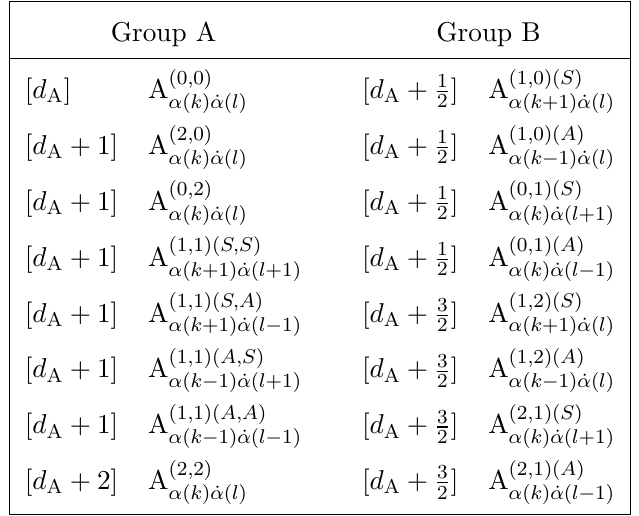
Table 1 . List of (cid:12)elds generated by super(cid:12)eld